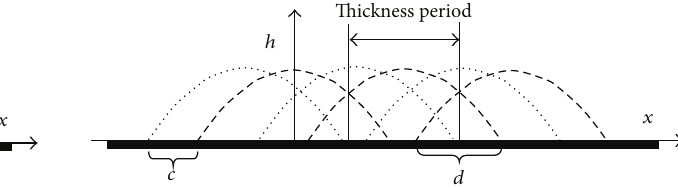
Figure 10: Painting when 0.5𝑑 < 𝑐 ≤ 𝑑 , 𝑐 + 𝑑 > 0.5 , 𝑐 + 2𝑑 > 1 and 𝑐 + 1.5𝑑 ≤ 1 .